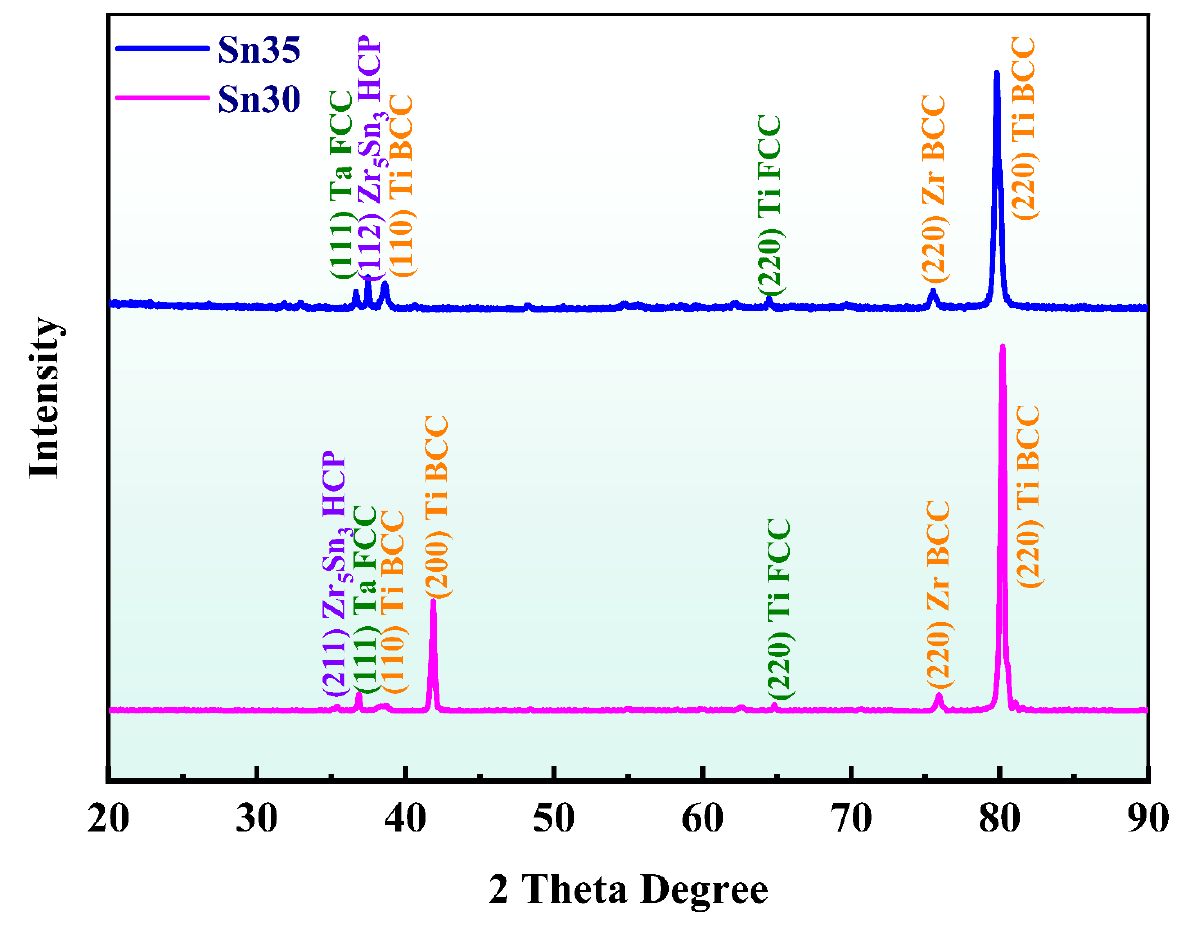
Figure 1. XRD patterns of Sn30 BHEA and Sn35 BHEA. Table 1. Thermodynamic parameters of Sn30 BHEA and Sn35 BHEA.